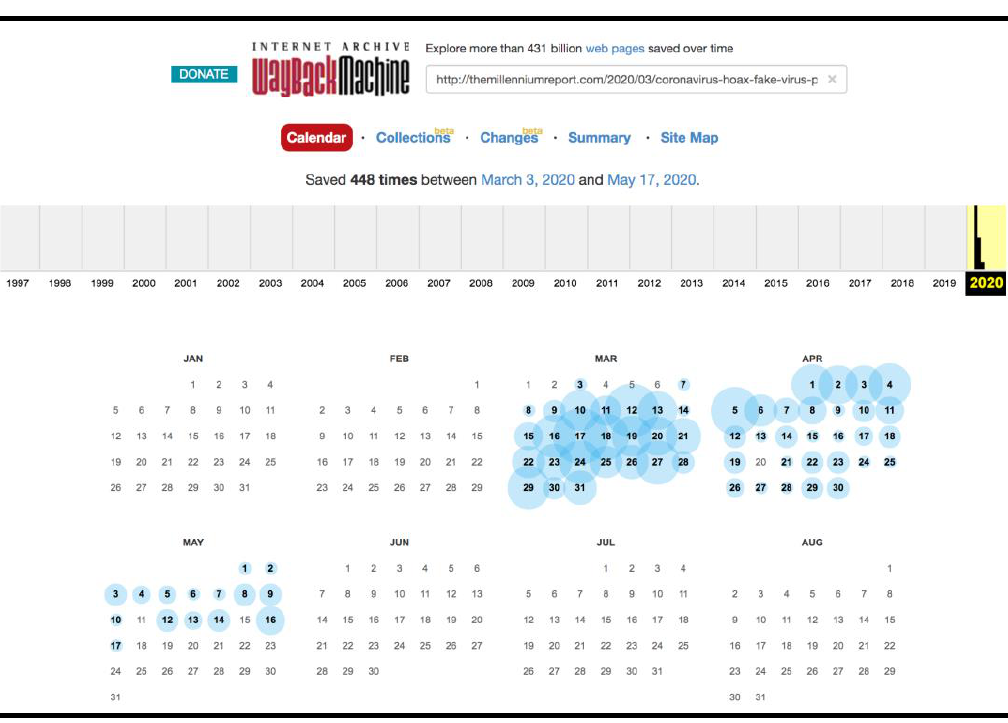
Figure 2. Calendar view from the Internet Archive Wayback Machine displaying 448 web crawl captures of The Millennium Report “CORONAVIRUS HOAX” article, from March 3, 2020 to May 17,